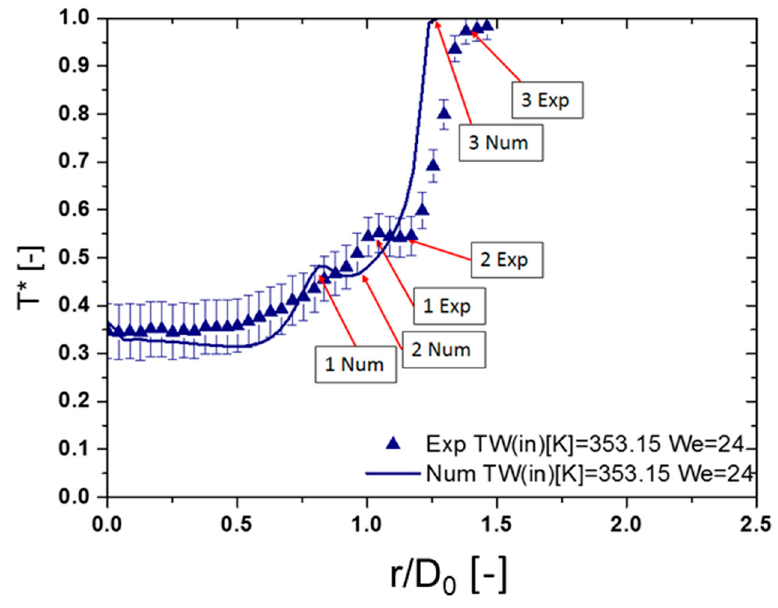
Figure 9. Measured and calculated temperature distribution along the dimensioless radial distance ( We = 24, Tw (in) = 353.15 K).